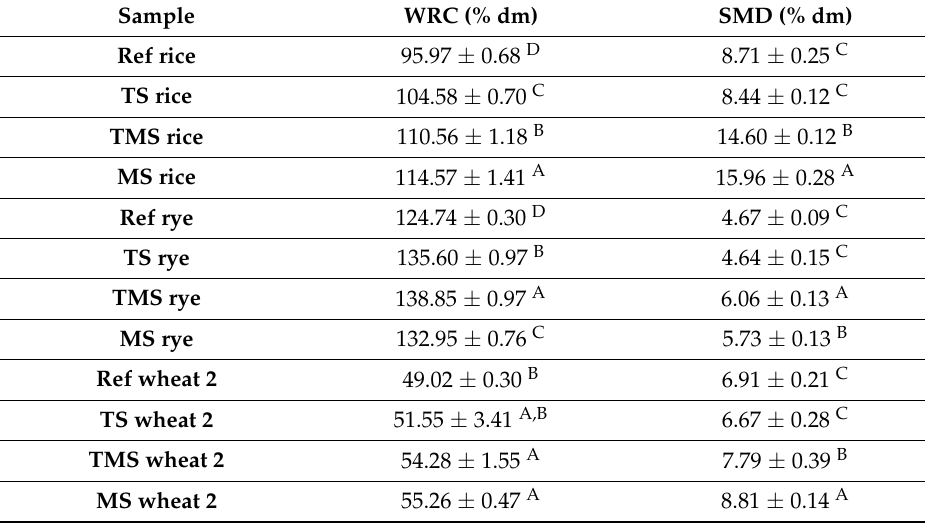
Table 3. Impact of thermal stress (TS) at 110 ◦ C, thermal-mechanical stress (TMS) in non-temperature- controlled grinder (18,000 rpm) and mechanical stress (MS) in temperature-controlled grinder (18,000 rpm) on mean ( ± SD) water retention capacity (WRC) and starch modification degree (SMD) of rice, rye and an additional wheat flour. SD = standard deviation; n =